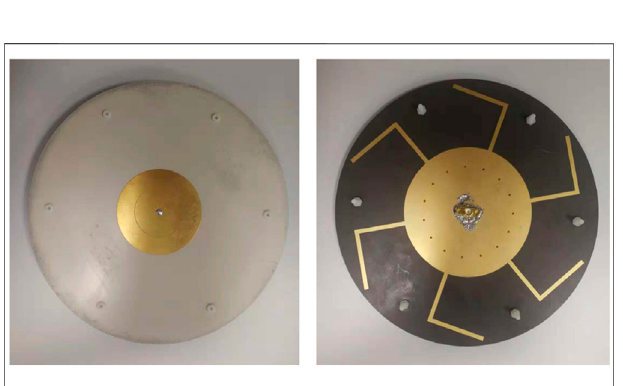
FIGURE 3 | Photograph of the proposed antenna.